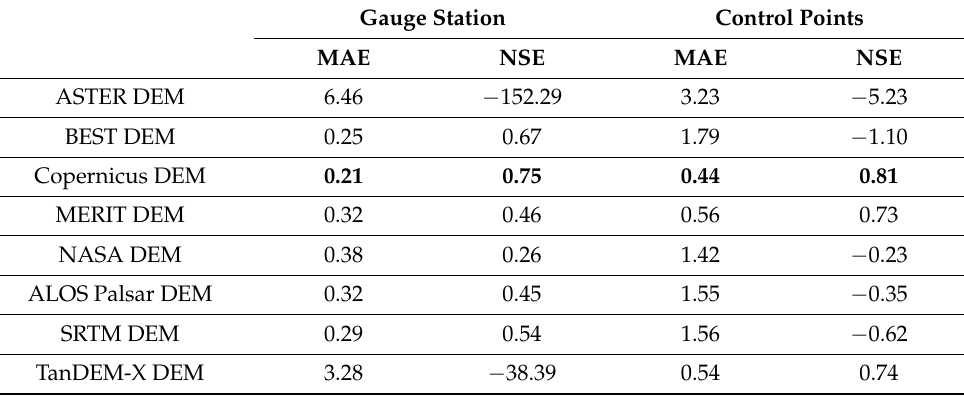
Table 3. Statistical results of the MAE and NSE index comparing hydrodynamic modelling and field